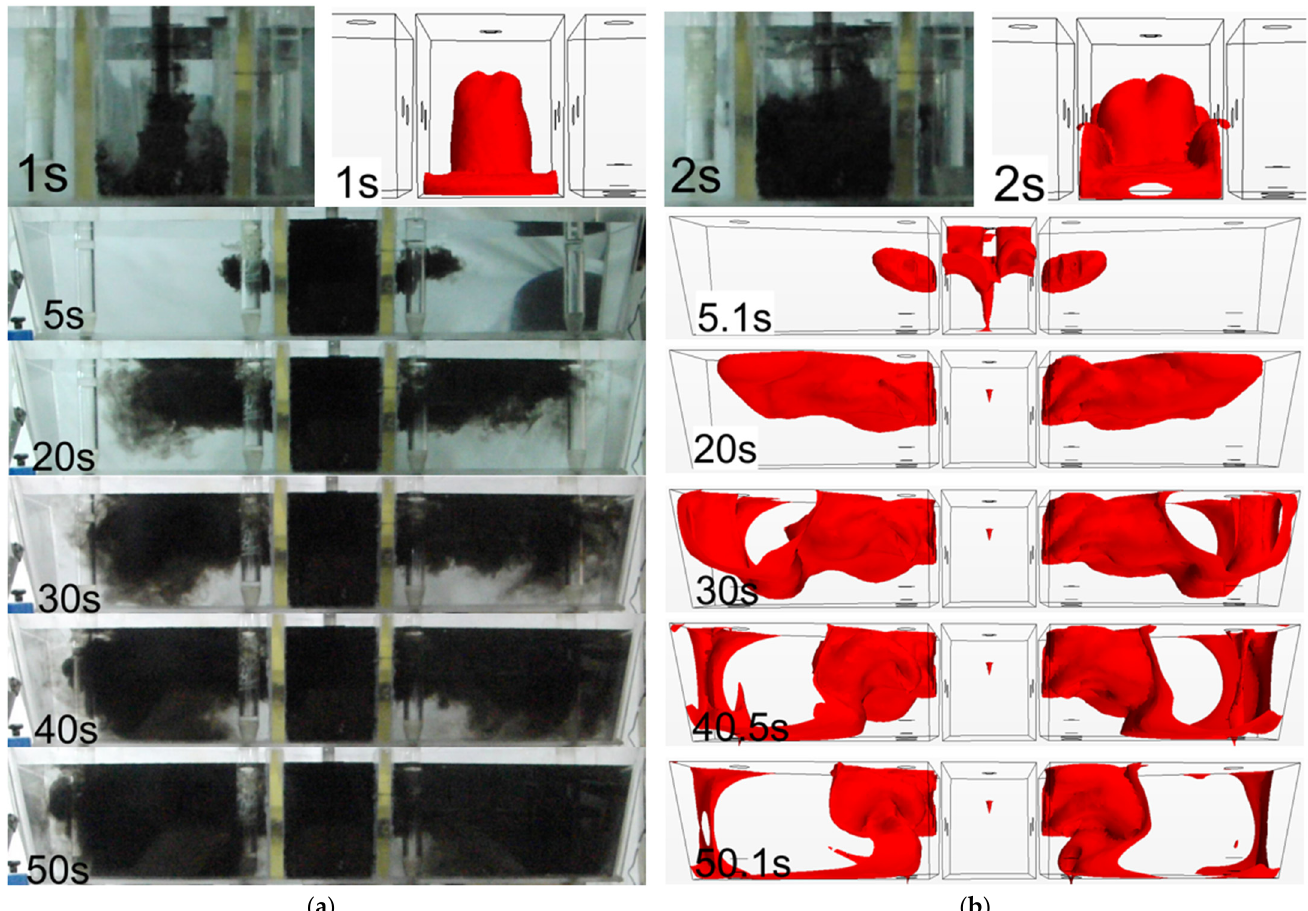
Figure 5. Comparison of ink diffusion photographs in water model and isosurface ( ω = 10 − 5 ) figures of numerical simulation results of double-weir tundish: ( a ) ink diffusion photographs, ( b ) isosurface figures.